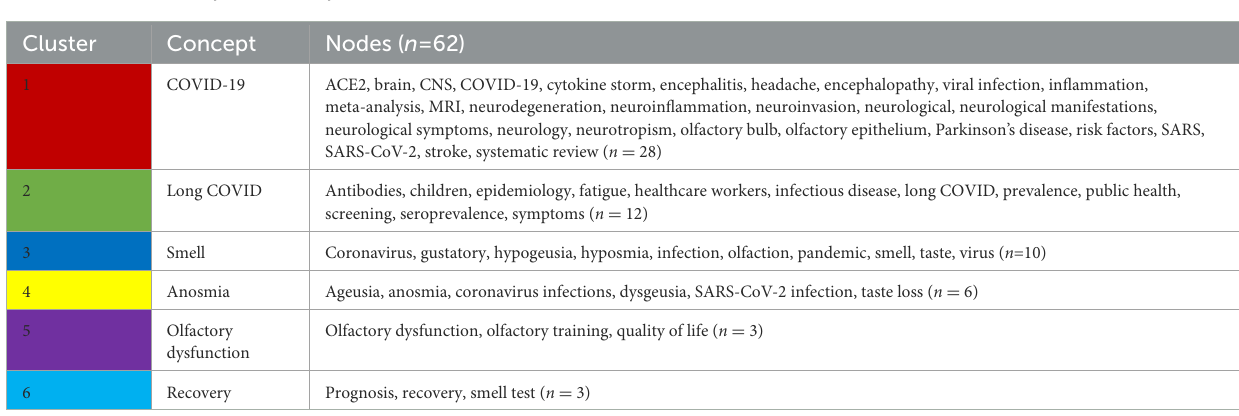
TABLE 5 Research concepts and hot